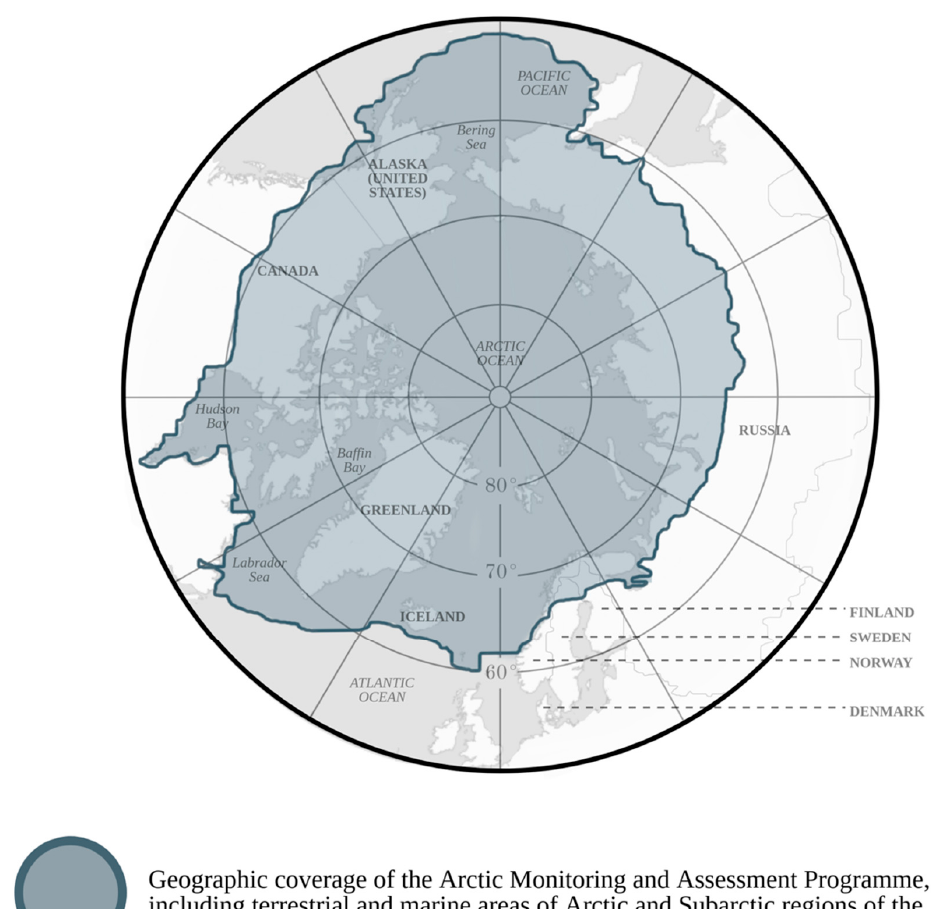
Figure A1. Map denoting the boundary area of Arctic and Subarctic regions of the Circumpolar North drawn from the geographic coverage defined by the Arctic Monitoring and Assessment Programme [170]. This boundary area includes terrestrial and marine areas of northernmost parts of eight Circumpolar countries (Canada, the Faroe Islands, Finland, Iceland, Norway, Sweden, Russia, and the United States) that were classified as Arctic or Subarctic climate regions under the Köppen classification system. This area extends as far south as 51.1°N to include areas north of the Aleutian chain, Hudson Bay, and parts of the North Atlantic Ocean, including the Labrador Sea.